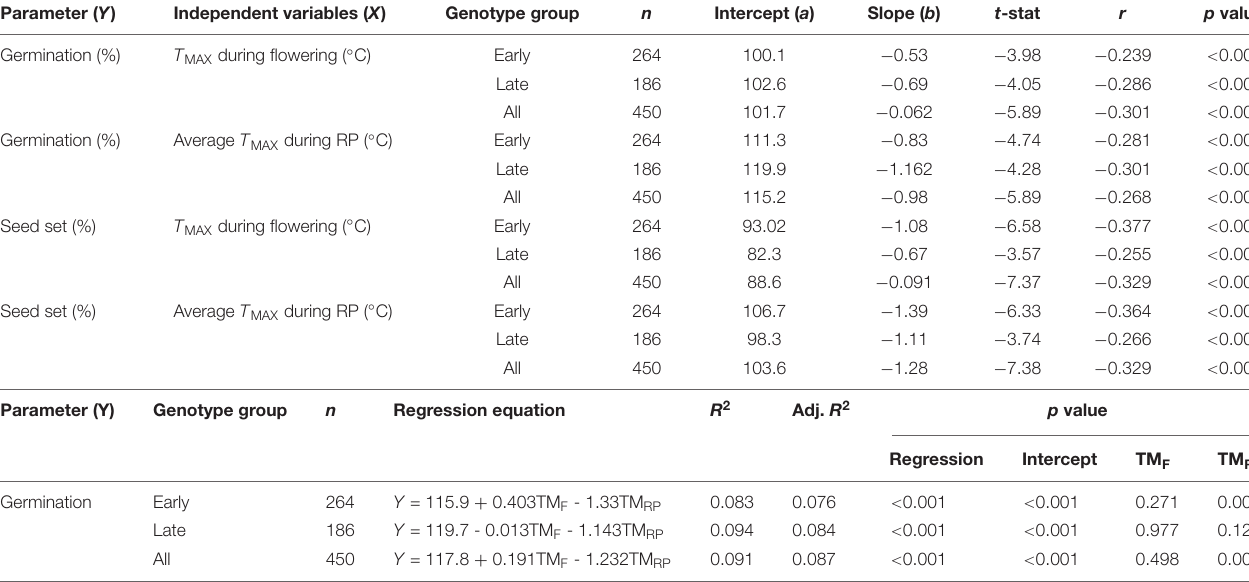
TABLE 3 | Regression equations and association between germination and seed set in field pea with ambient maximum temperature.